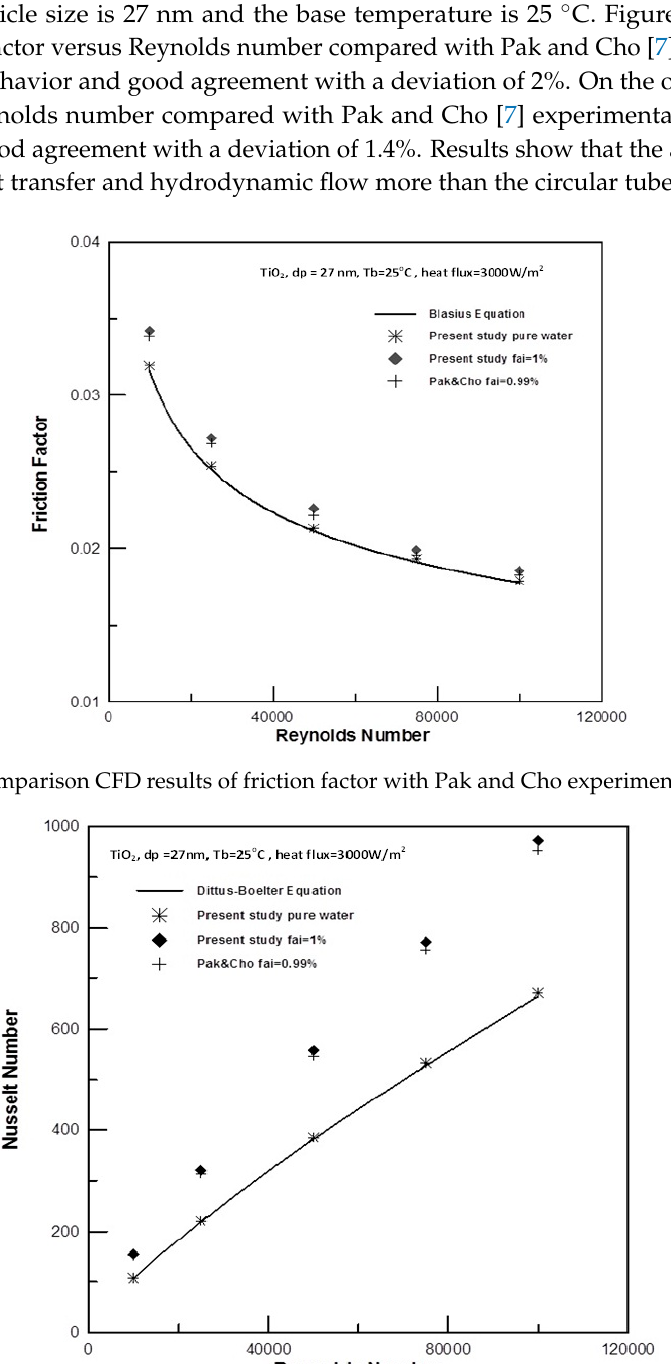
Figure 4. The effect of particles size diameter. ( a ) The effect of particle size diameter on friction factor with Reynolds number; ( b ) the effect of particles size diameter on Nusselt number with Reynolds number.